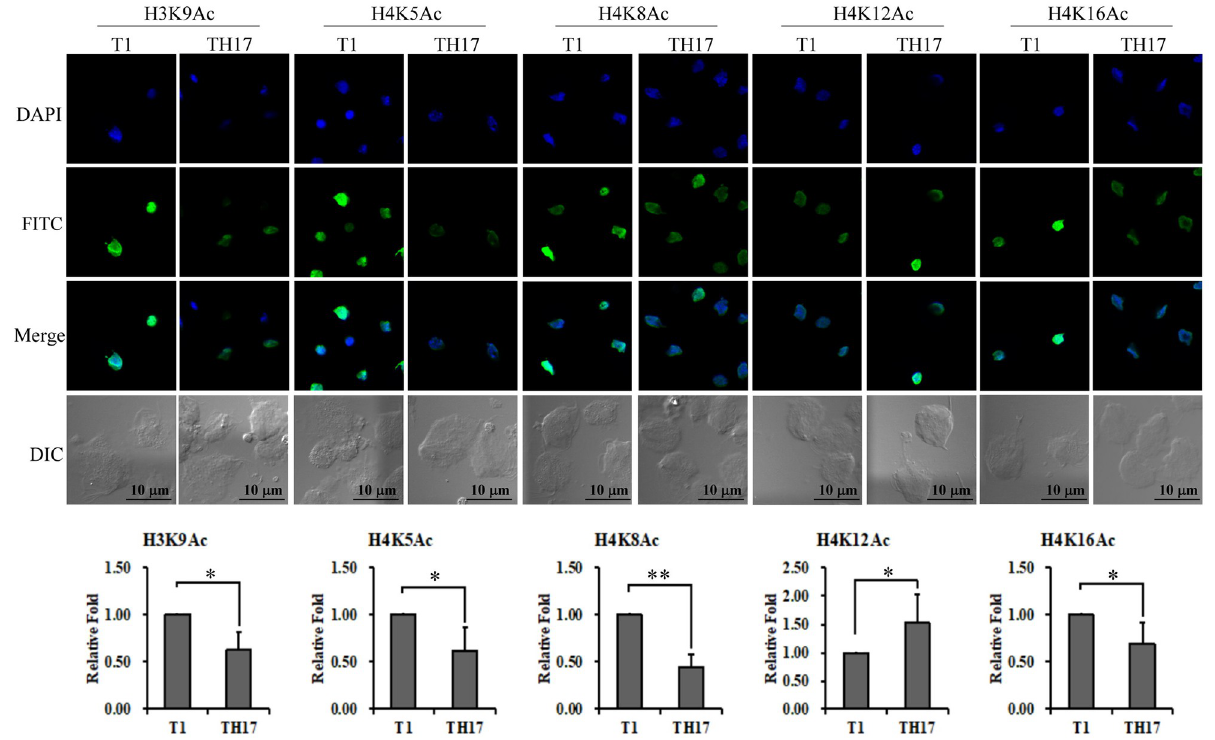
Fig 8. Epigenetic divergence of adherent versus nonadherent T . vaginalis isolates. Site-specific histone acetylation in T . vaginalis was examined by IFA using the antibodies as indicated on the top of each panel. The cell morphology was observed by microscopy at DIC mode. Scale bar represents 5 μ m. The relative intensities of nuclear signals were quantified as shown in the bar graphs (n = 3, mean ± SD). Significant differences were statistically analyzed by Student’s t-test with P < 0.01( �� ) or P < 0.05 ( � ).